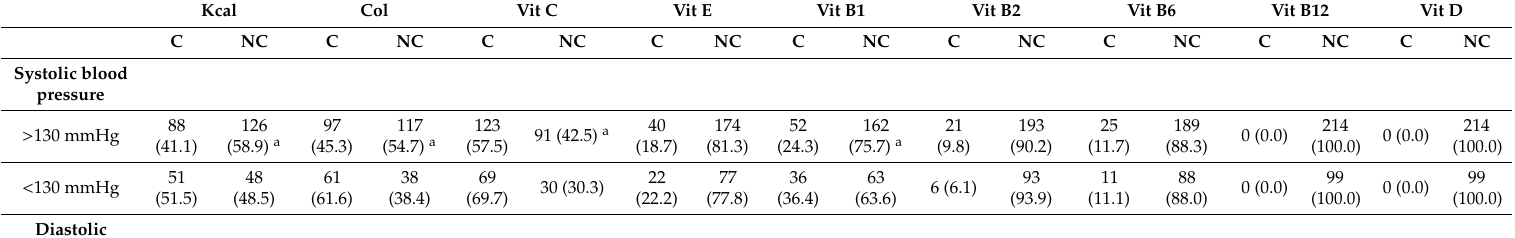
Table 6. Relationship between sociodemographic variables and compliance with daily intake recommendations for vitamins, energy, and